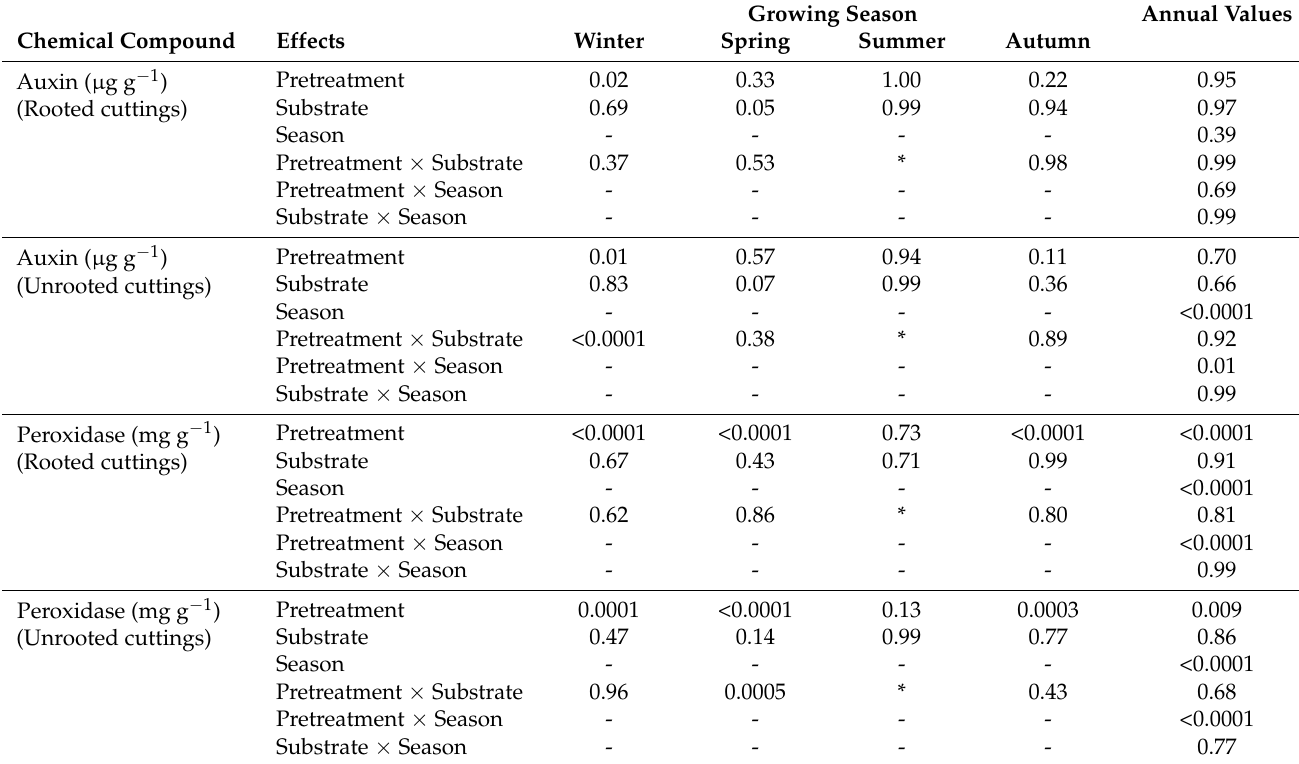
Table 2. Results of multifactor ANOVA of effects of main factors on auxin and peroxidase composition of stem cuttings across seasons. p -values for principal effects (IBA pretreatment, substrate, and season, and their two-way interactions) and for effects within each season (pretreatment, substrate, and their interaction) are given. Effects were significant at p <